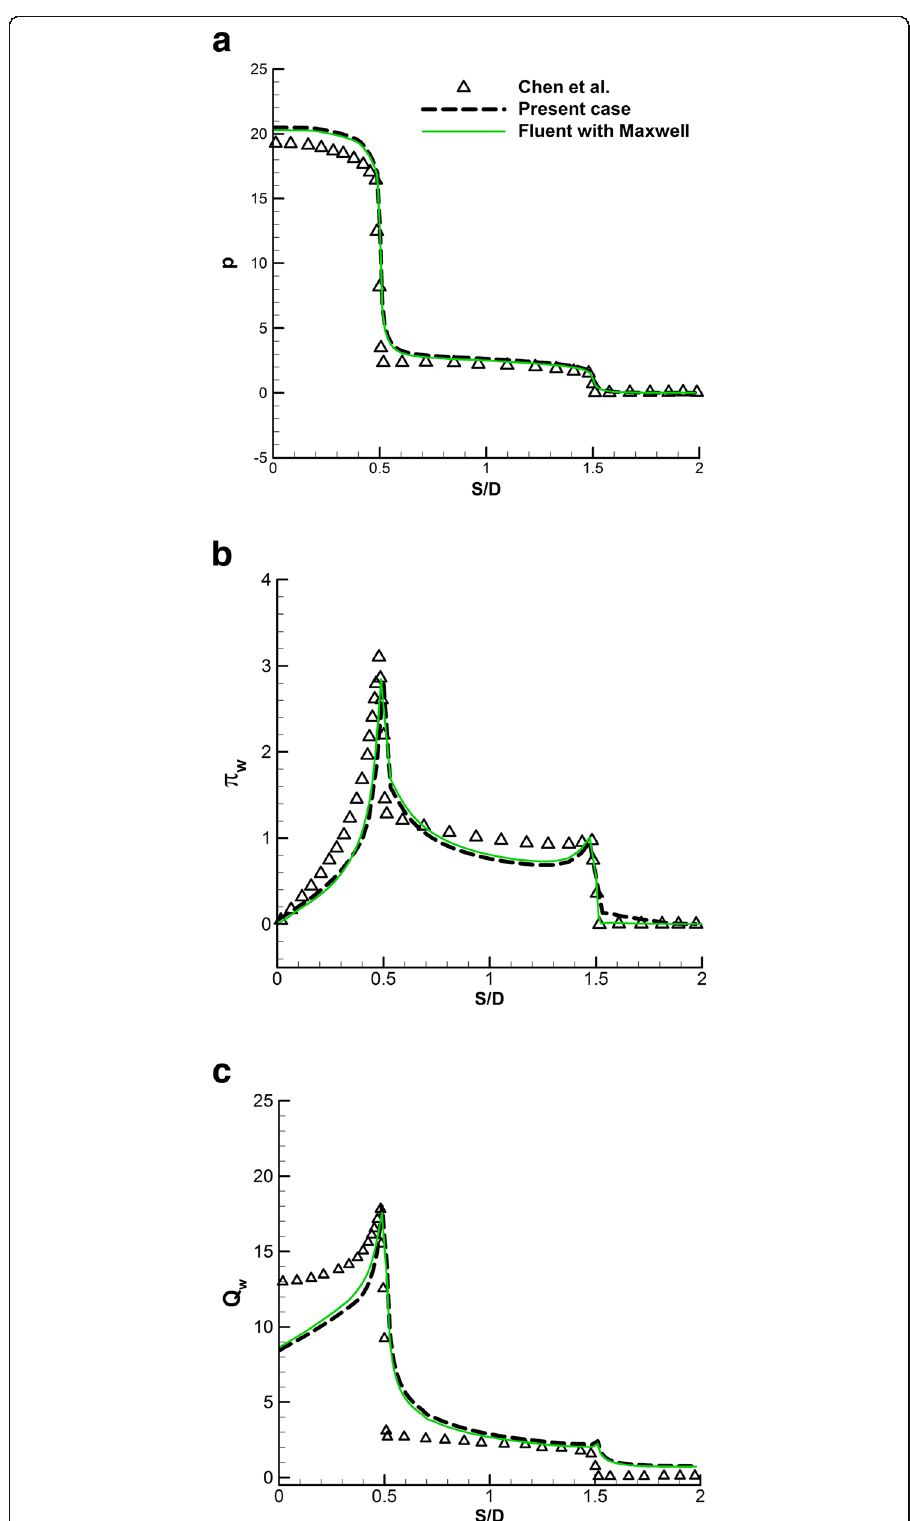
Fig. 5 Comparison of surface quantities measured along the surface of the cylinder at Kn = 0.1 and M = 5.0 with the FLUENT solutions obtained using the Maxwell/Smoluchowski conditions and the Chen et al. [50] results: a pressure, b shear stress, and c heat